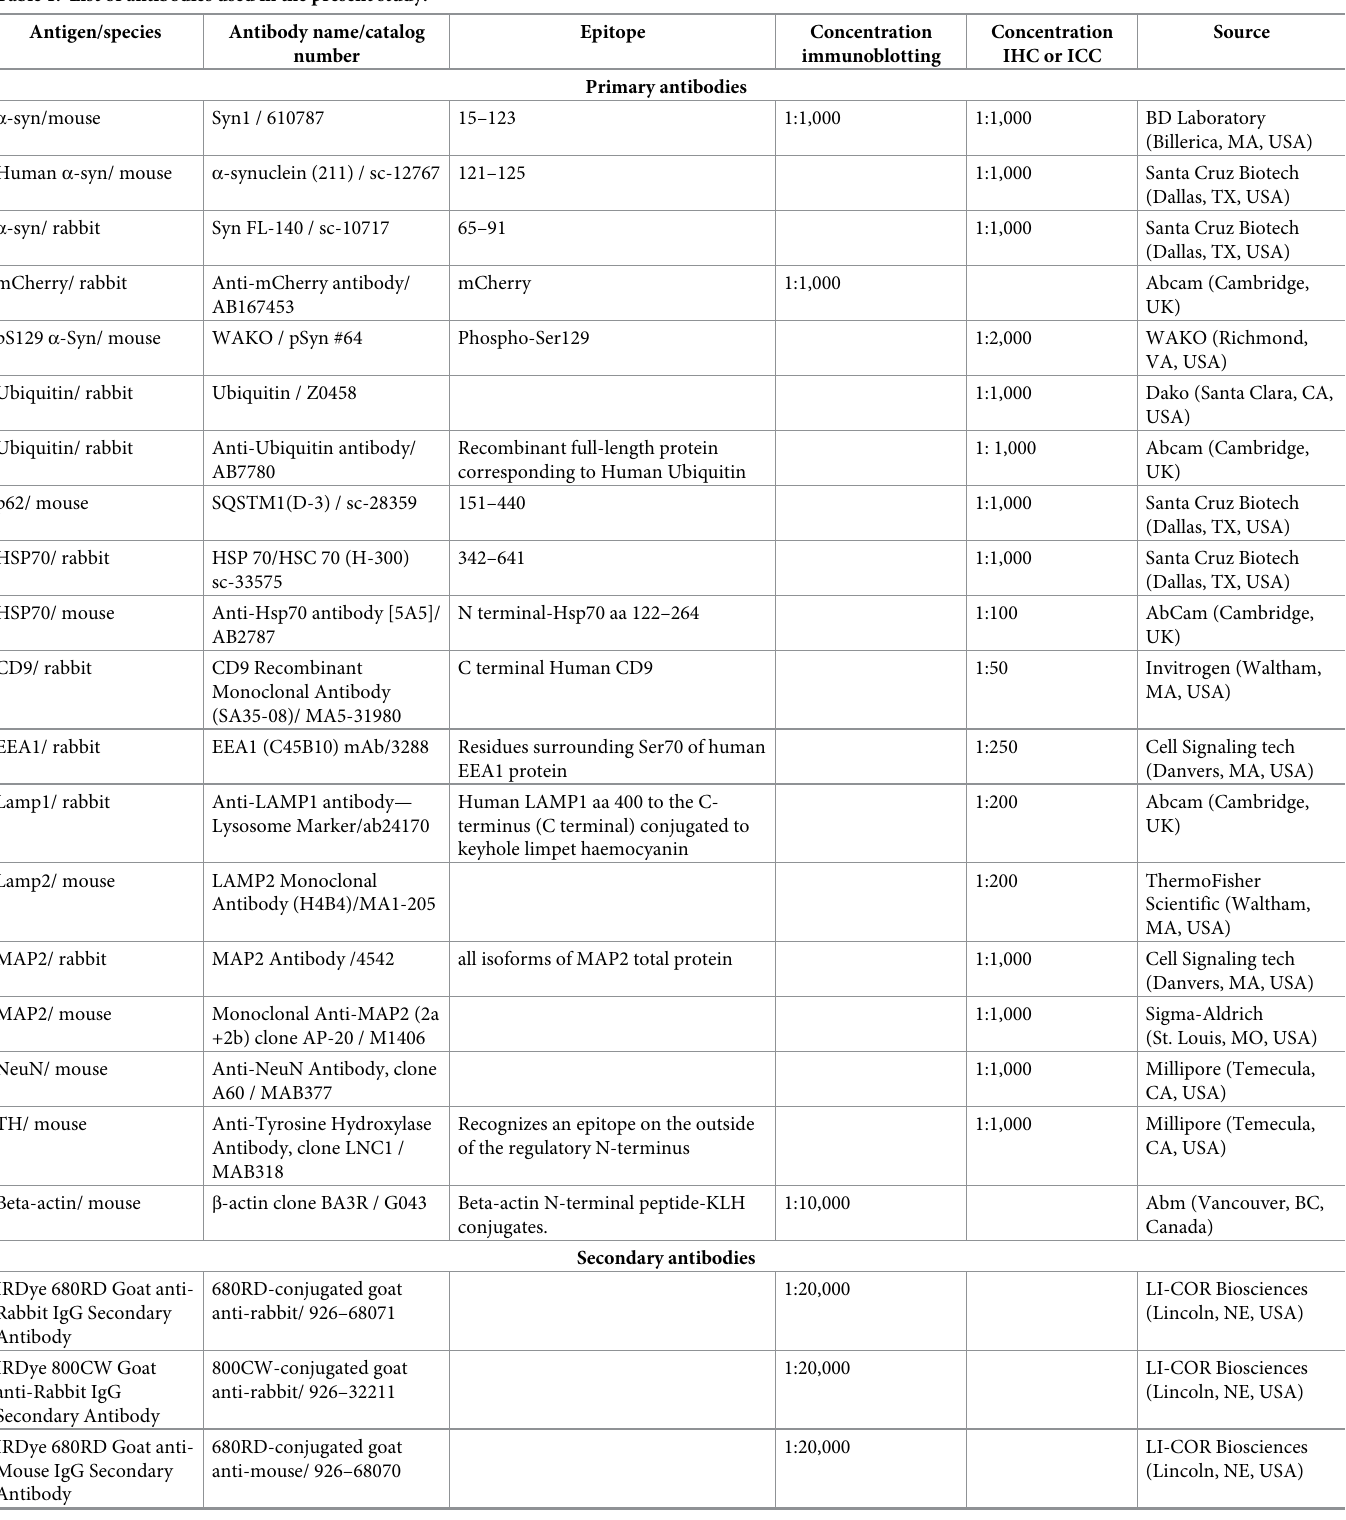
Table 1. List of antibodies used in the present study.